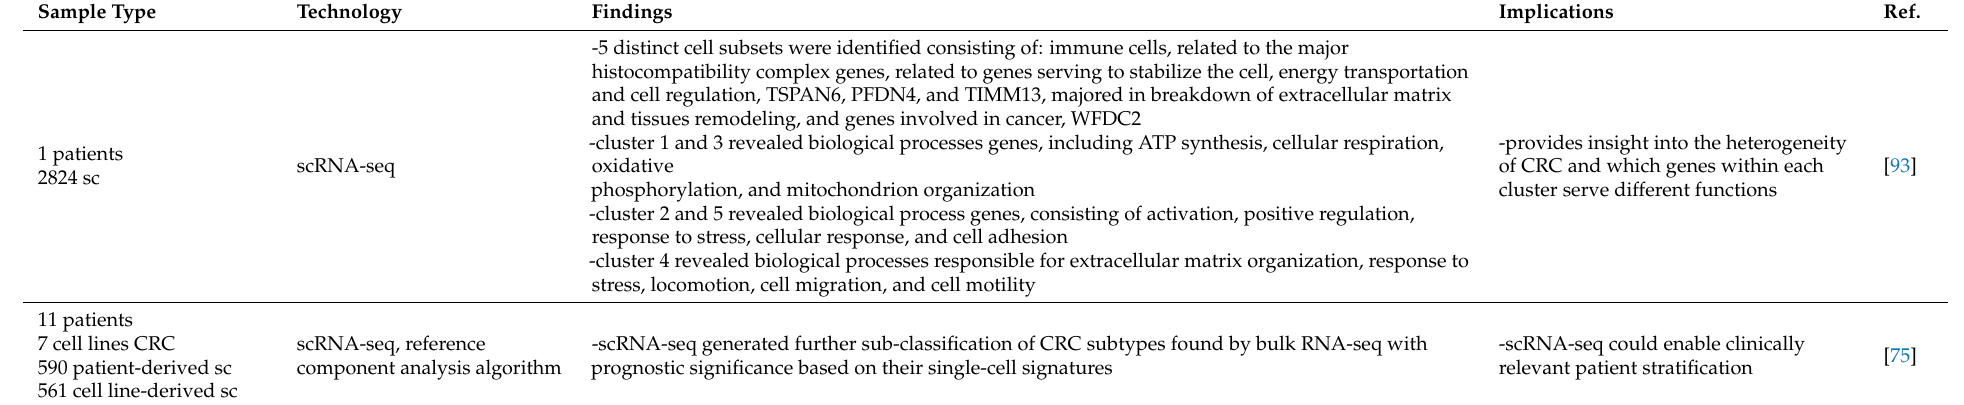
Table 1. Summary of advances of single-cell sequencing and editing technologies into precision medicine in the colorectal